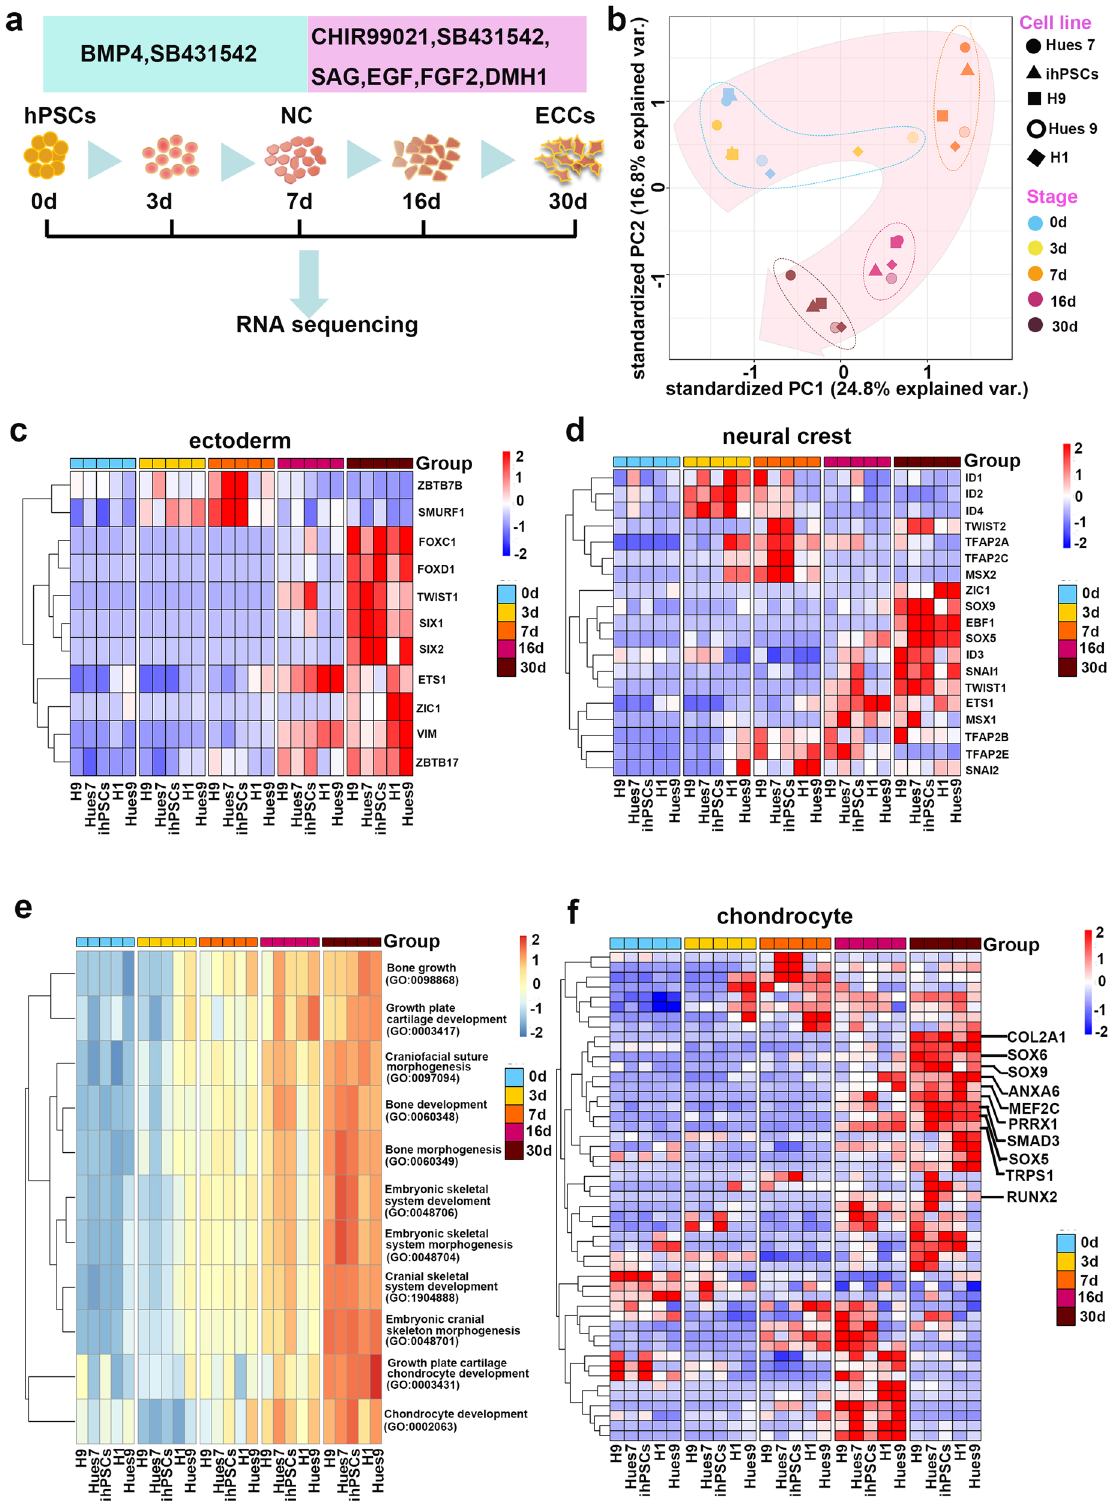
Fig. 1 Generation of NC-derived progenitor cells from hPSCs. a Schematic representation of the NC-derived progenitor cell induction process. b PCA indicates that fi ve unique hPSC (H1, Hues9, H9, Hues7 and ihPSC) lines followed similar differentiation trajectories. c Genes encoding ectoderm markers were upregulated during induction. d Genes encoding NC markers were upregulated during induction. e GO analysis highlighted bone and cartilage development, especially cranial skeleton morphogenesis and cranial skeletal system development, in NC-derived progenitor cells. f Genes encoding chondrogenesis markers were upregulated during